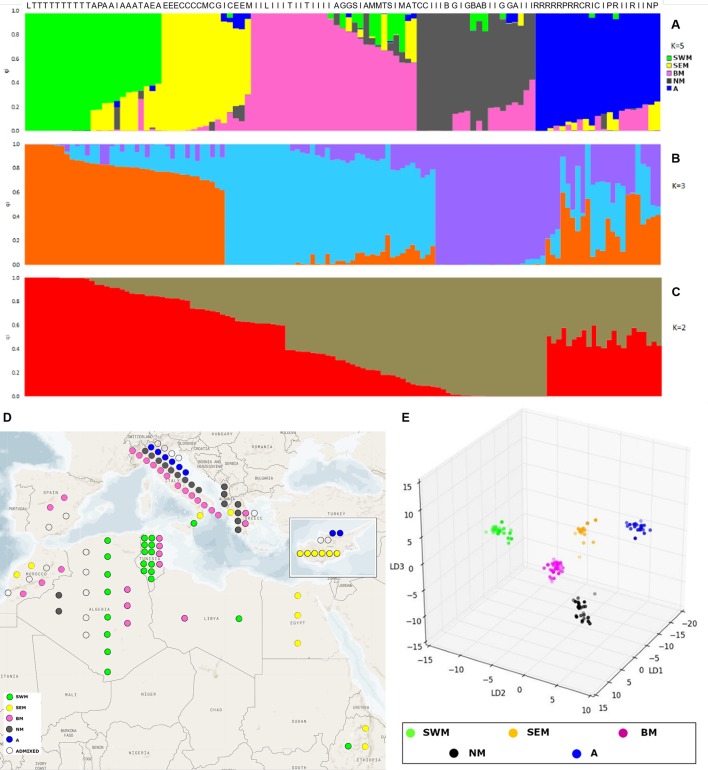
Analysis of genetic structure with the STRUCTURE admixture model and discriminant analysis of principal components (DAPC). STRUCTURE results are shown for models with two (A), three (B), and five (C) subpopulations, associated with the highest values of the Evanno’s ΔK statistics. Each individual is represented by a vertical line, which is partitioned into colored segments whose length depends on the estimated membership fraction (qi) in each subpopulation. Letters over the bars indicate the country of origin of individual accessions: Algeria (A), Cyprus (C), Greece (G), Italy (I), Lybia (L), Morocco (M), Pakistan (P), Spain (S), and Tunisia (T). (D) highlights the geographic origin of the Mediterranean accessions characterized by STRUCTURE analysis. (E) presents the three-dimensional scatter plot resulting from DAPC applied to k-means clusters.